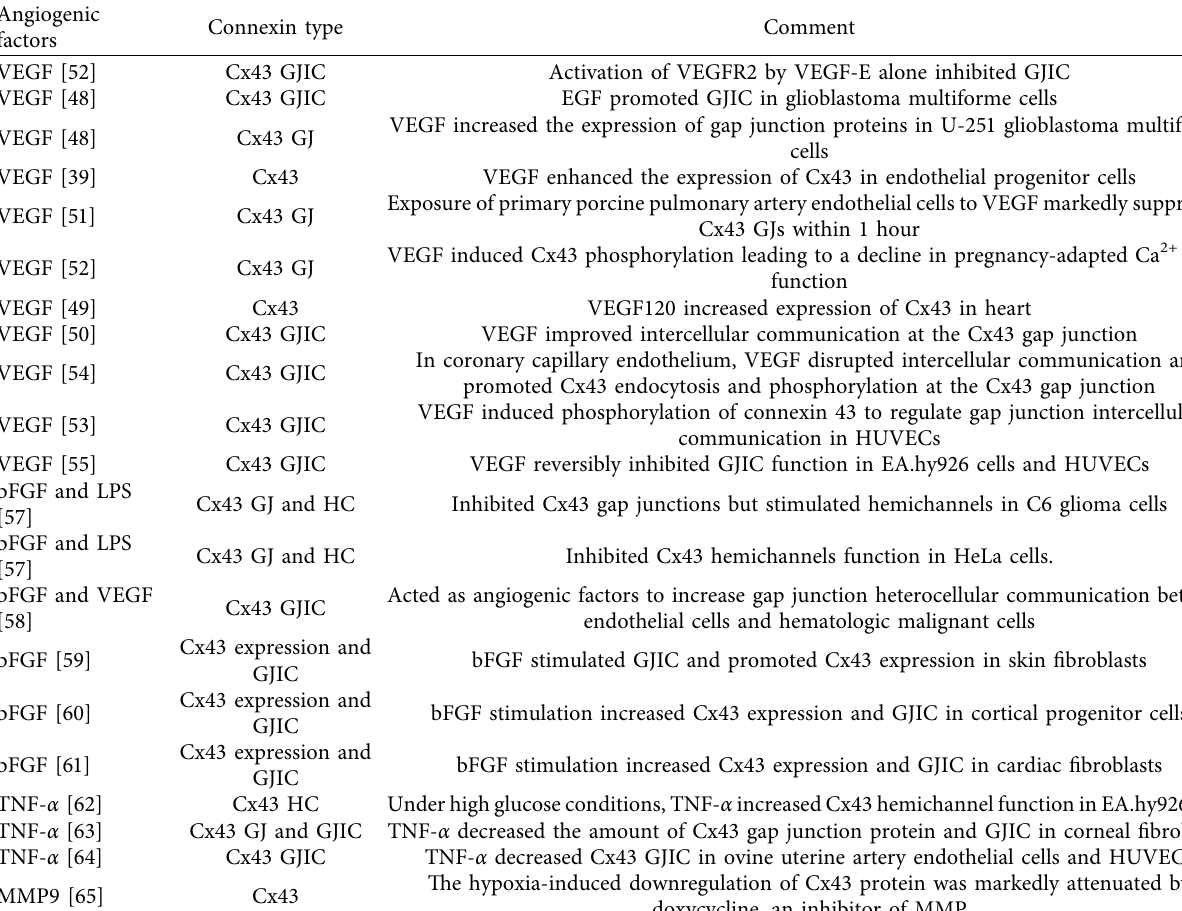
Table 2: Effect of angiogenic factors on